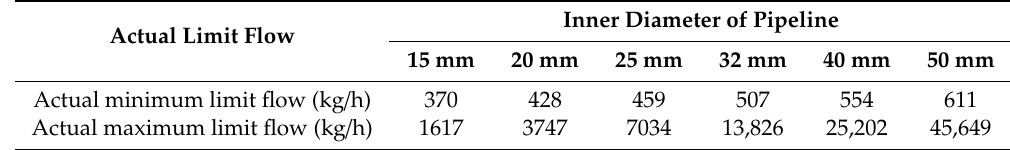
Table 1. Flow range of pipeline transportation of liquid CO 2 with di ff erent